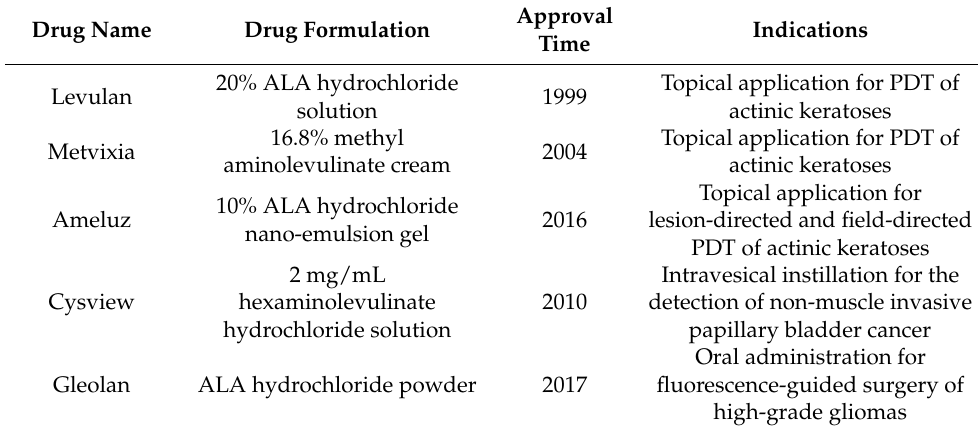
Table 1. ALA and its derivative drugs currently approved by the U.S.